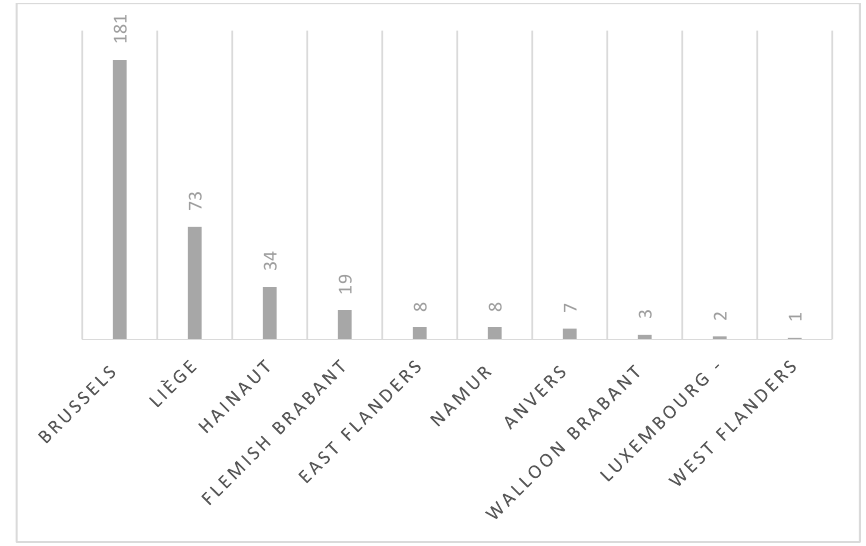
Figure 1. Geographical distribution all around Belgium of cases of tinea capitis collected during the study ( n = 336, one localization not known).